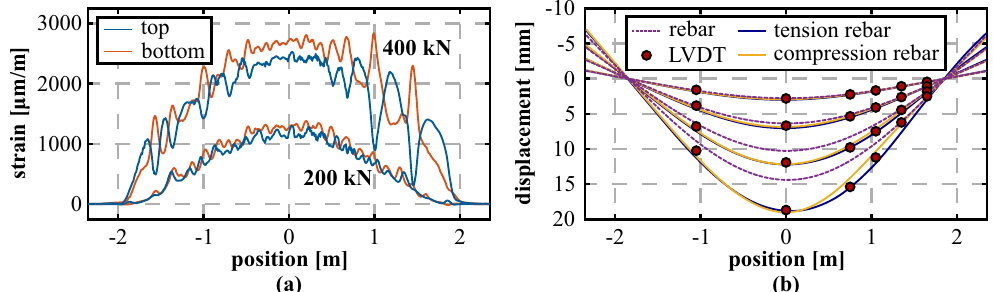
Figure 11. Optimized sensing approach along the reinforcement: ( a ) Strain profiles measured along two layers of tension reinforcement. ( b ) Derived displacement curves.